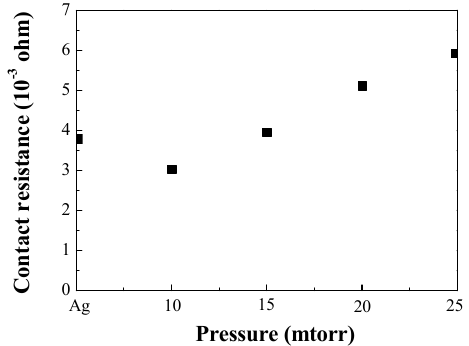
Figure 3. Contact resistance for metal/GAZO interface as a function of sputtering pressure.